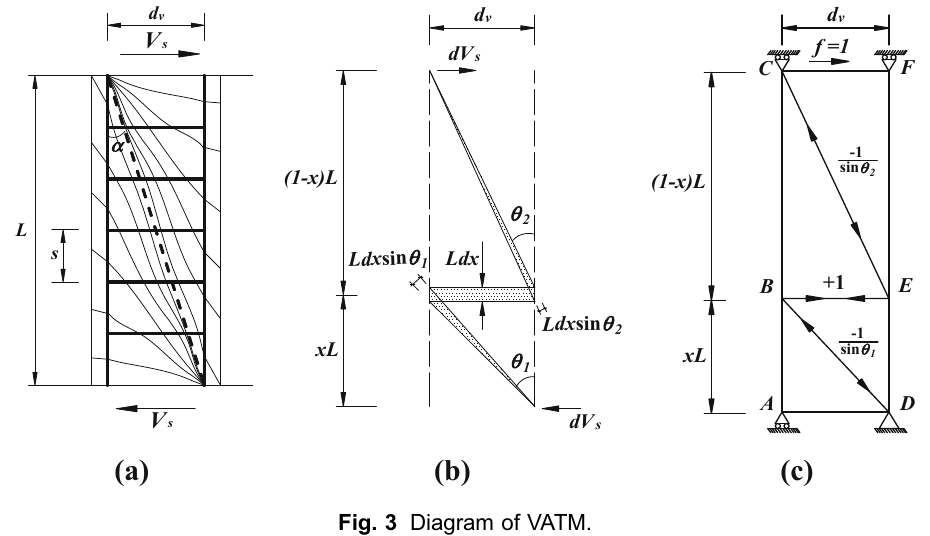
Fig. 3 Diagram of VATM.